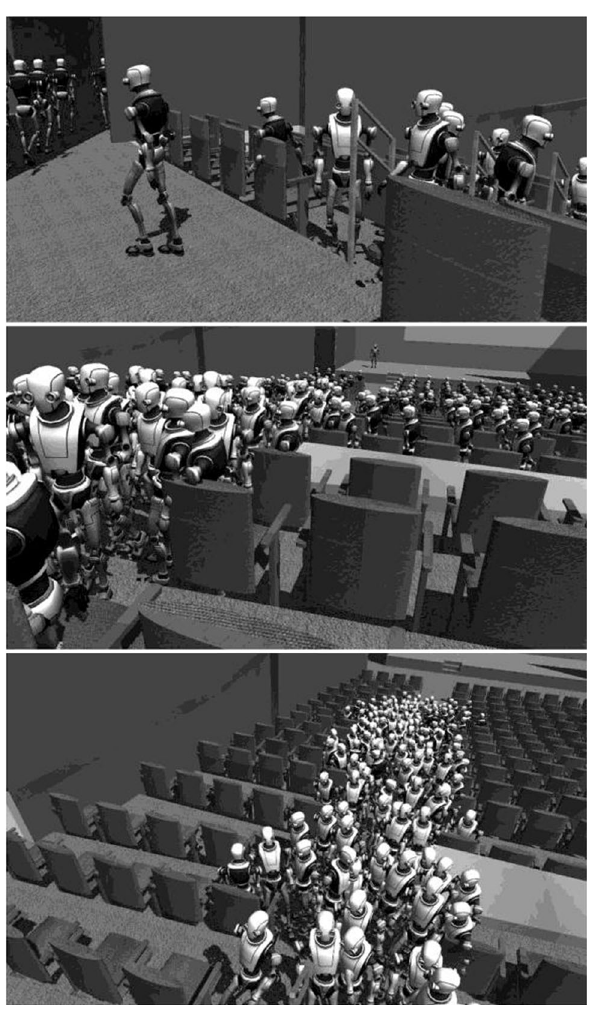
Fig. 1 Evacuation simulation and crowd behavior study. AI-con- trolled avatars evacuate from lecture hall in DAAP building. University of Cincinnati (UC). By Laura Kennedy, University of Cincinnati